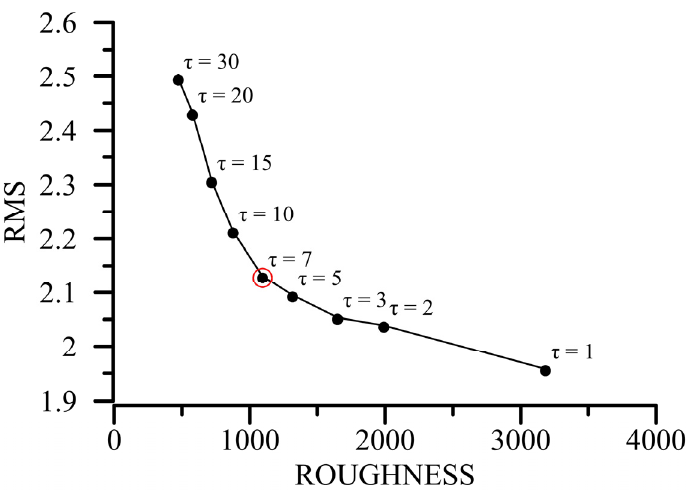
Figure 3. L-curve showing the variation in RMS values and model roughness when using different regularization parameters.